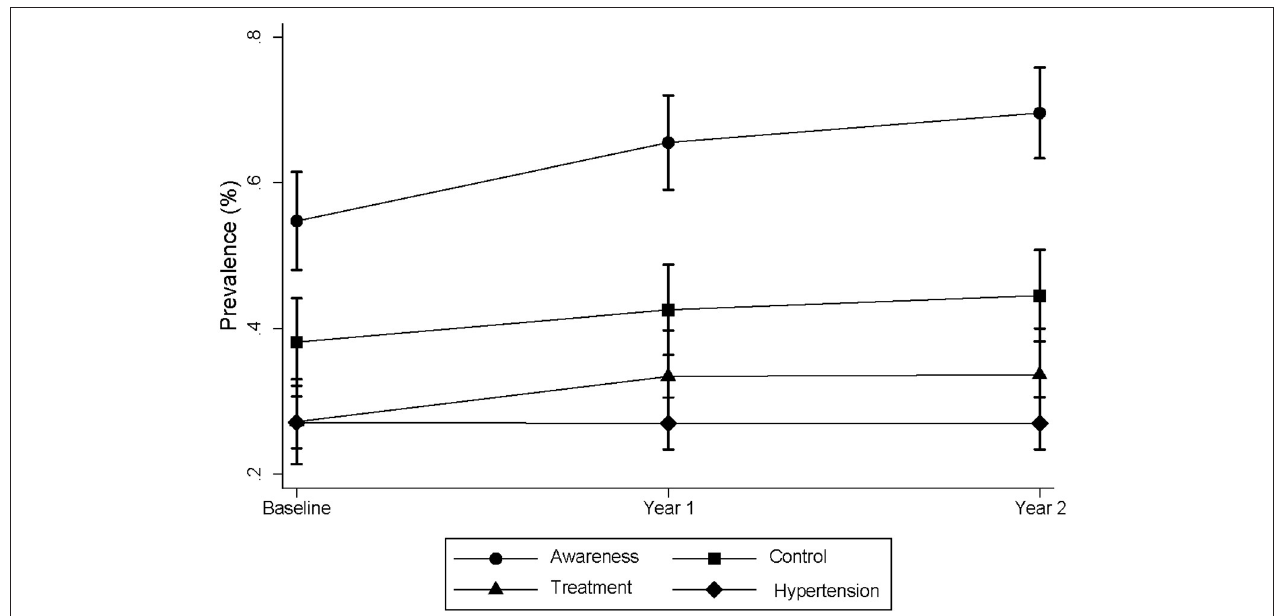
FIGURE 2 | Trends of prevalence of hypertension awareness, treatment and control cross 2 years. The data was obtained from the K-DPP participants with repeated measures. There were 1,007 participants at baseline, 981 at year 1 and 962 at year 2. For hypertension, there were 274 at baseline, 265 at year 1 and 260 at year 2. The prevalence of awareness, treatment, and control were calculated among those who were hypertensive per definition at each time point.